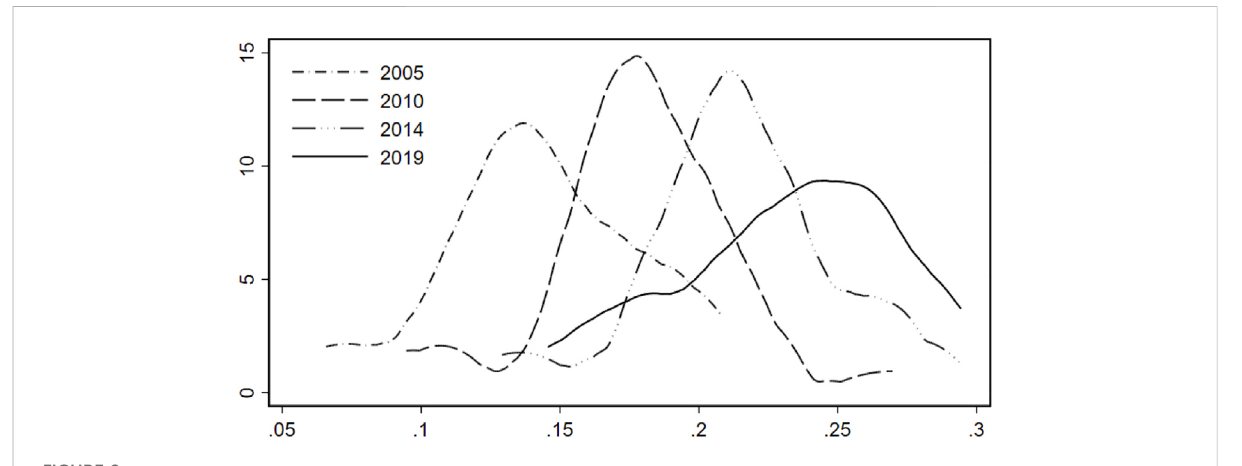
FIGURE 2 Kernel density distribution of coupling